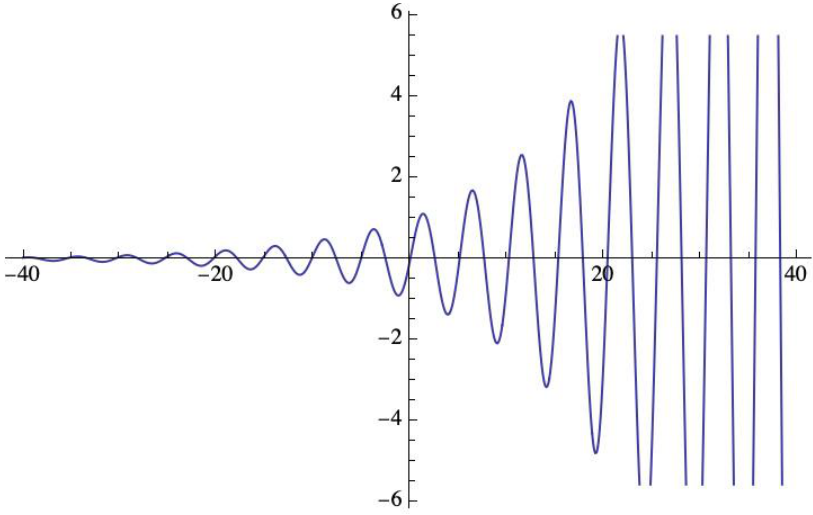
Figure 2. Mathematica plot of Im ( u 2 ) with a = 1, A = − 3, c =